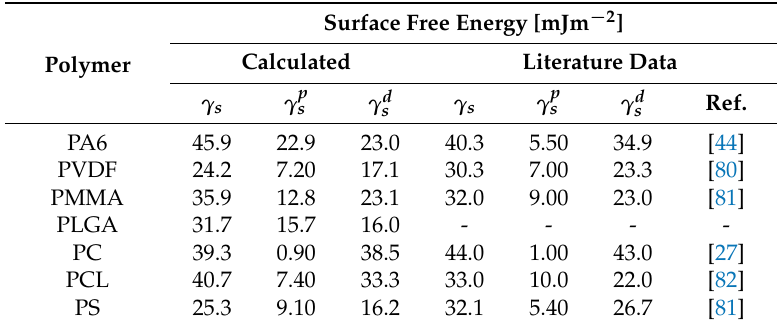
Table 6. Summaries of surface free energy calculated for all polymer films based on Owens-Wendt plots shown in Figure 6 with data found in the literature and